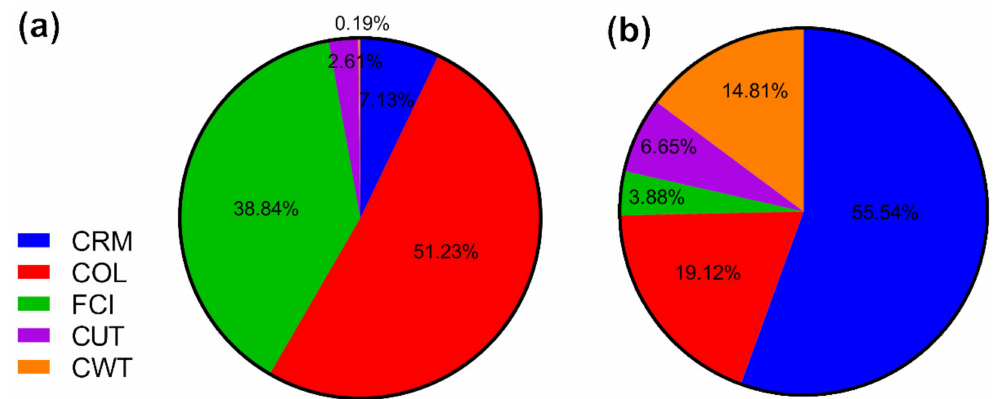
Figure 6. Contribution of each component. CRM: cost of raw material; FCI: fixed capital investment; COL: cost of operational labor; CUT: cost of utilities on the COM for quinoa protein hydrolysate obtained by supercritical fluids; extraction (SFE) for ( a ) laboratory scale and ( b ) industrial scale.